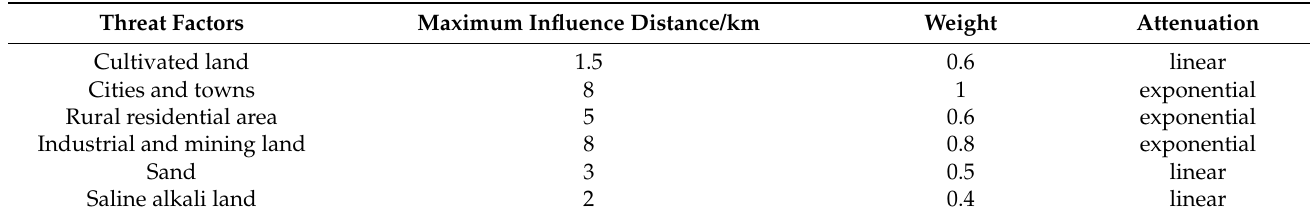
Table 4. Threat source and its maximum threat distance, weight, and attenuation type.